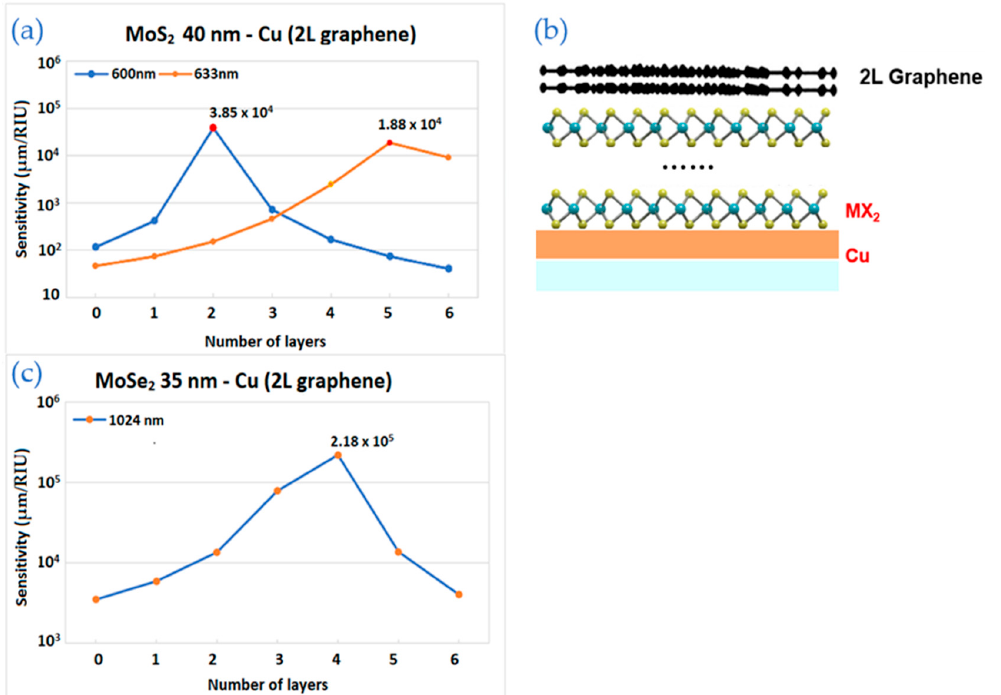
Figure 6. The sensitivity values of the enhanced model with 2 layers of graphene by TMDC layers and thickness of copper: ( a ) The wavelengths are 600 nm and 633 nm for MoS 2 layers with 40 nm of copper; ( b ) the schematic structure; ( c ) The wavelength is 1024 nm for MoSe 2 layers with 35 nm of